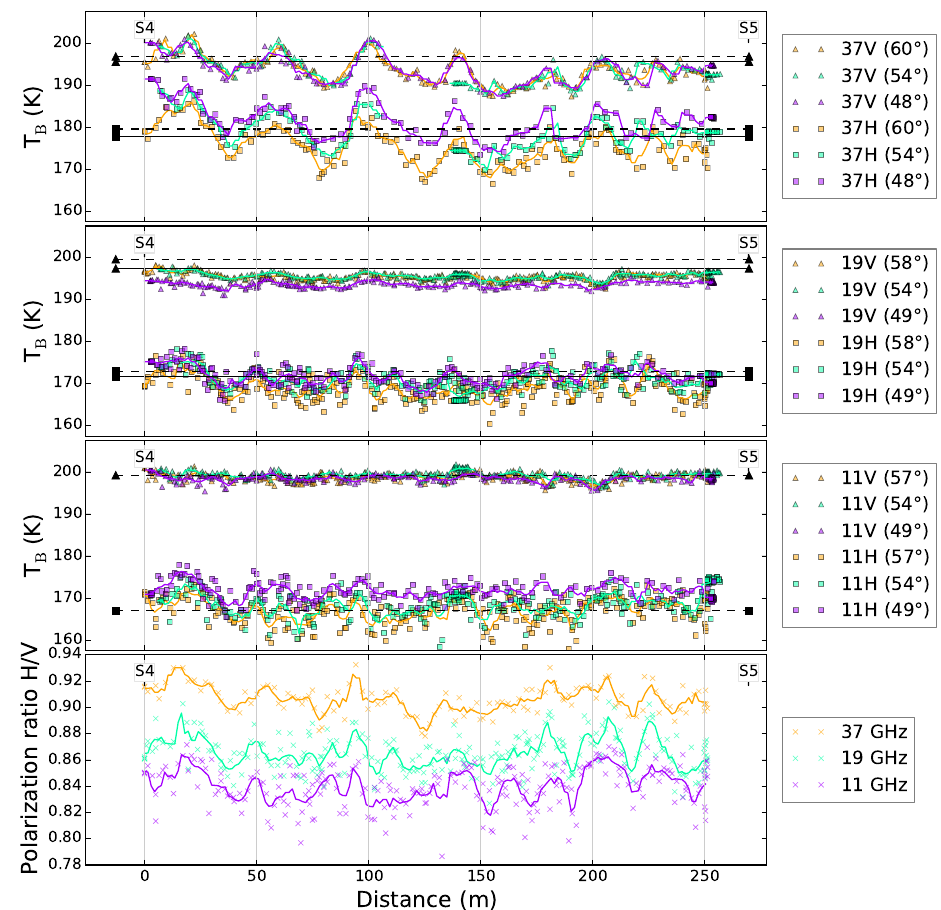
Figure 5. Brightness temperature (three top plots) and polarization ratio (bottom plot) measured along the S4–S5 transect at three frequencies (11, 19 and 37GHz) and for various incidence angles. The symbols represent individual measurements at vertical polarization (triangles), horizontal polarization (squares) and polarization ratio (cross). The curves show the running average with a 12m window. The horizontal black lines show the mean brightness temperature during the campaign of the pixel containing Dome C from SSM/I (solid line) and WindSat (dashed